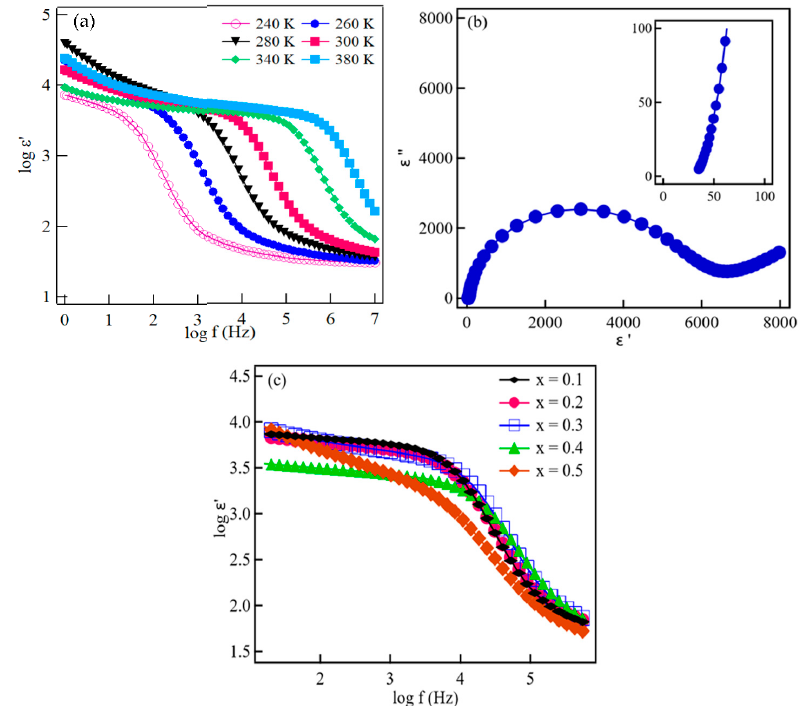
Figure 7. ( a ) ε ’ spectra for LLT-Ga1 at selected temperatures as a representative sample and ( b ) the Cole-Cole diagram at 280 K for LLT-Ga1 with the inset showing high magnification of the high frequency region. ( c ) ε ’ spectra for all Li 5+2x La 3 Ta 2-x Ga x O 12 compositions at 300 K.